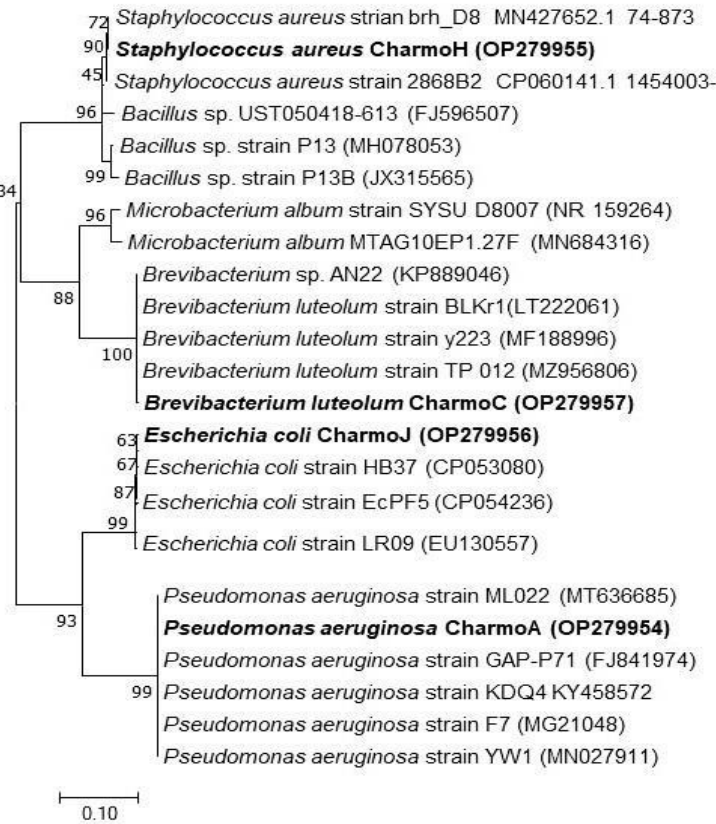
Figure 8. Phylogenetic sketch of E. coli , P. aeruginosa , B. luteolum , and S. aureus on the basis of the nucleotide sequence similarity of the 16S rRNA gene. The new isolates of the current study are denoted in bold. The access numbers of the 16S rRNA bacterial genes that were used to create the phylogenetic sketch are written in the brackets. The ClustalX and MEGA 7 programs, using the neighbor - joining method, bootstrapped with 1000 replicate runs, are used in creating the tree.